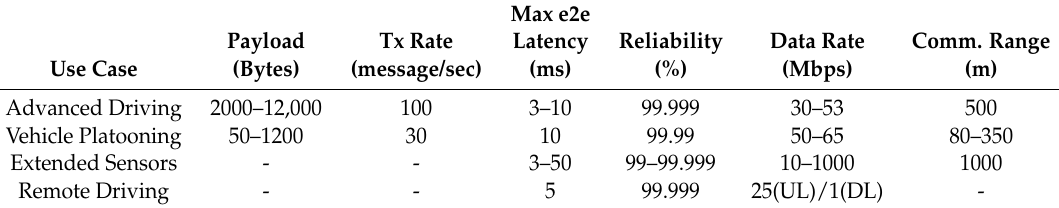
Table 3. Performance requirements for highly automated use cases according to 3GPP TS 22.186